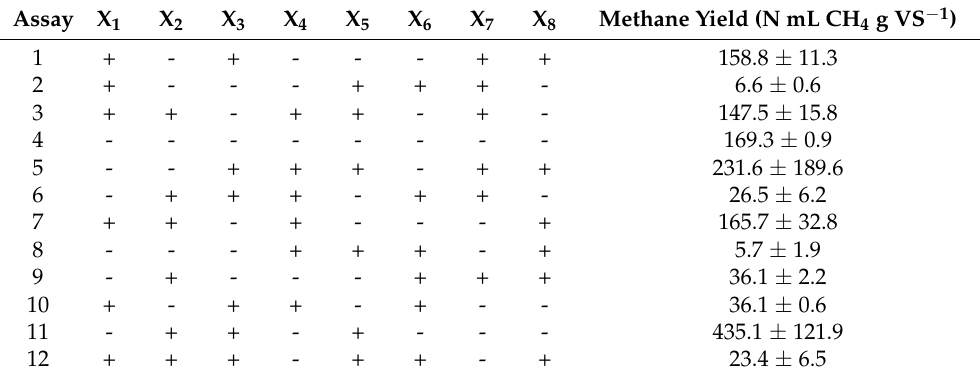
Table 4. Experimental matrix of the Plackett–Burman design and methane yield values obtained (average value ±